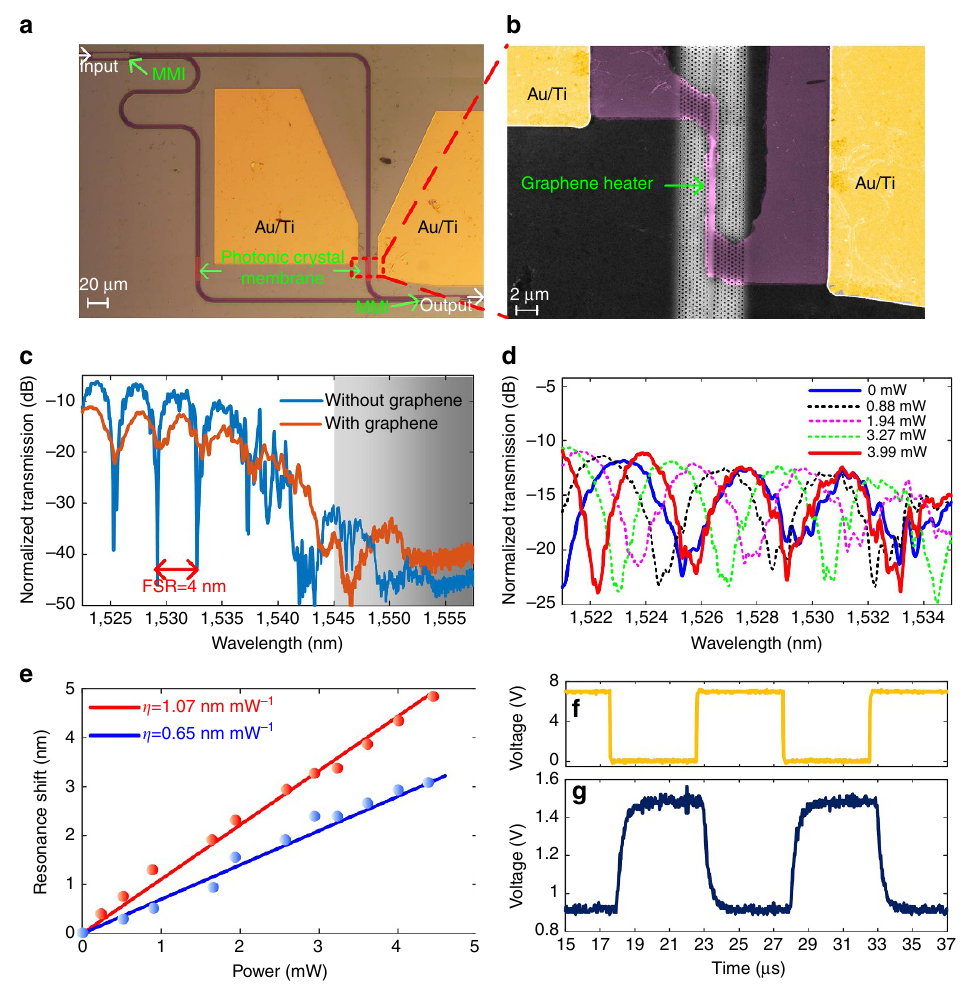
Figure 2 | Characterization of the slow-light-enhanced graphene microheater. ( a ) Microscope image of the entire MZI device. ( b ) False-colour scanning electron microscope image of the slow-light-enhanced graphene heater. ( c ) Measured and normalized transmission spectra for the MZI with (red line) and without (blue line) graphene. The grey-shaded area indicates the bandgap area of the PhCW. ( d ) Static response of the heating power. ( e ) Measured resonance shifts for the interference dips at 1525.12nm (blue) and 1533.71nm (red) as functions of the applied heating power. ( f ) Driving electrical signal and ( g ) corresponding temporal response